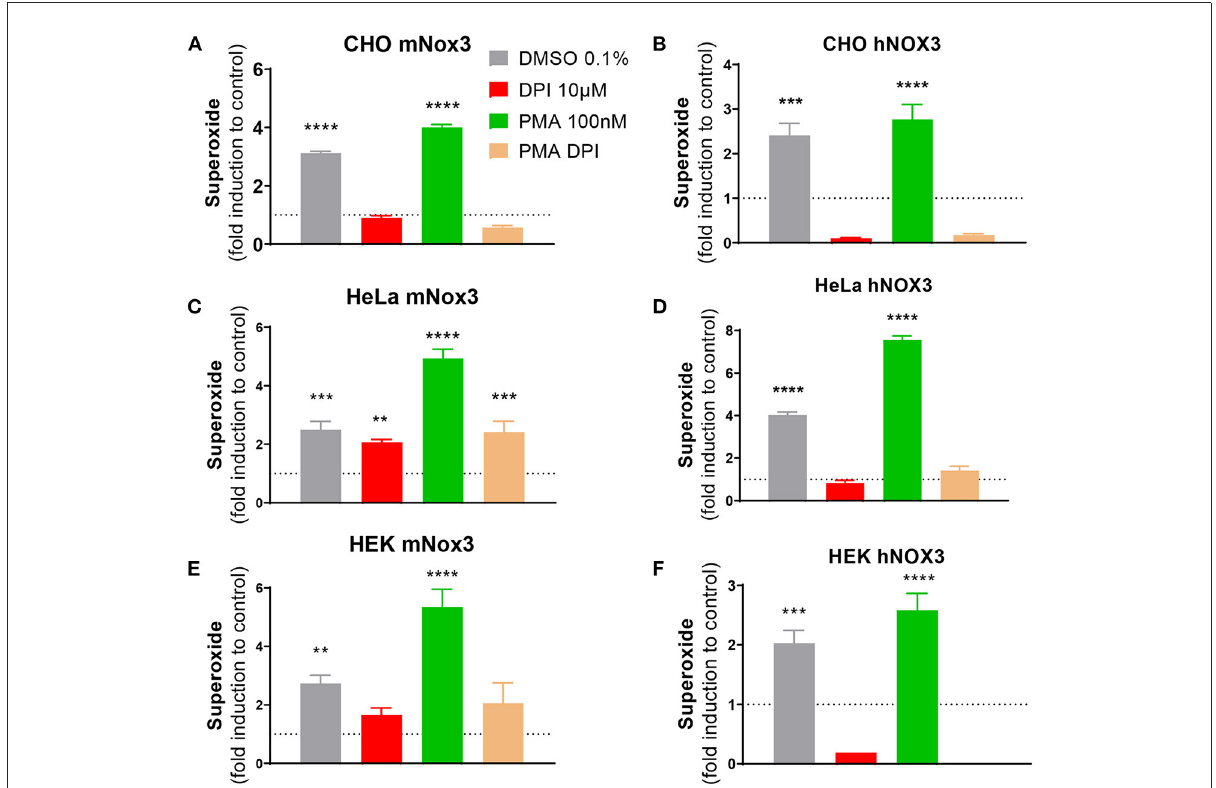
FIGURE1 Characterization of NOX3 activity in three cell lines expressing the mouse or human NOX3 complex. ROS production was evaluated in (A,B) CHO, (C,D) HeLa and (E,F) HEK293 transduced with all subunits of (A,C,E) mouse (mNox3) or (B,D,F) human NOX3 complex (hNOX3) by using a colorimetric WST-1 assay, detecting superoxide. Bar graphs represent NADPH activity of NOX3 in cells treated with DMSO, the NOX3 agonist PMA and/or the NOX inhibitor DPI. Data from every experimental condition was compared and normalized to the untransduced control (WT) for each cell type. DMSO, dimethyl sulfoxide; PMA, phorbol 12-myristate 13-acetate; DPI, diphenyliodonium. Data represent the average of three independent experiment + - SEM.